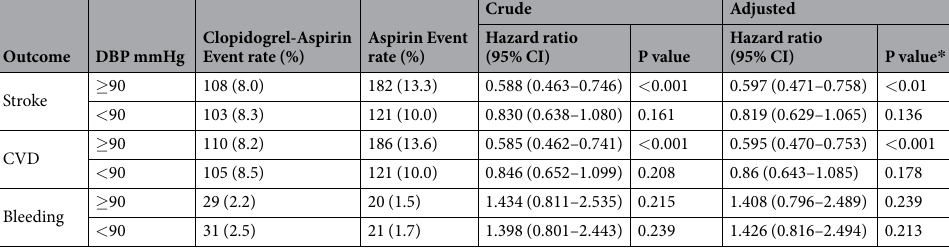
Table 3. Effects of dual and mono antiplatelet therapy on outcomes by DBP levels. * Adjusted for gender, age, body mass index, history of TIA or ischemic stroke, hypertension, hypercholesterolemia, diabetes mellitus, current or previous smoking, moderate to heavy drinking, qualifying event, antihypertensive drugs, lipid- lowering agent and antidiabetic agent. Abbreviations: CVD = combined vascular events (ischemic stroke, hemorrhagic stroke, myocardial infarction, or vascular death); DBP = diastolic blood